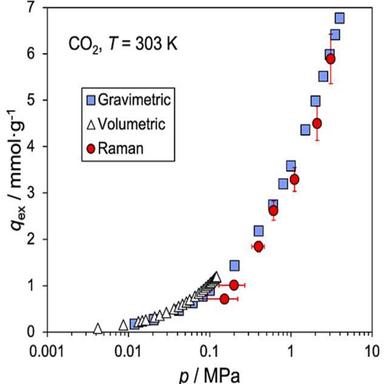
Excess adsorption capacity of CO2 on silica gel adsorbent, measured directly via Raman Spectroscopy and compared with the results from volumetric and gravimetric sorption analyzers. Uncertainty in adsorption capacity measurement (Raman) and associated pressure measurement are indicated by the vertical and horizontal error bars, respectively (note the logarithmic pressure scale).